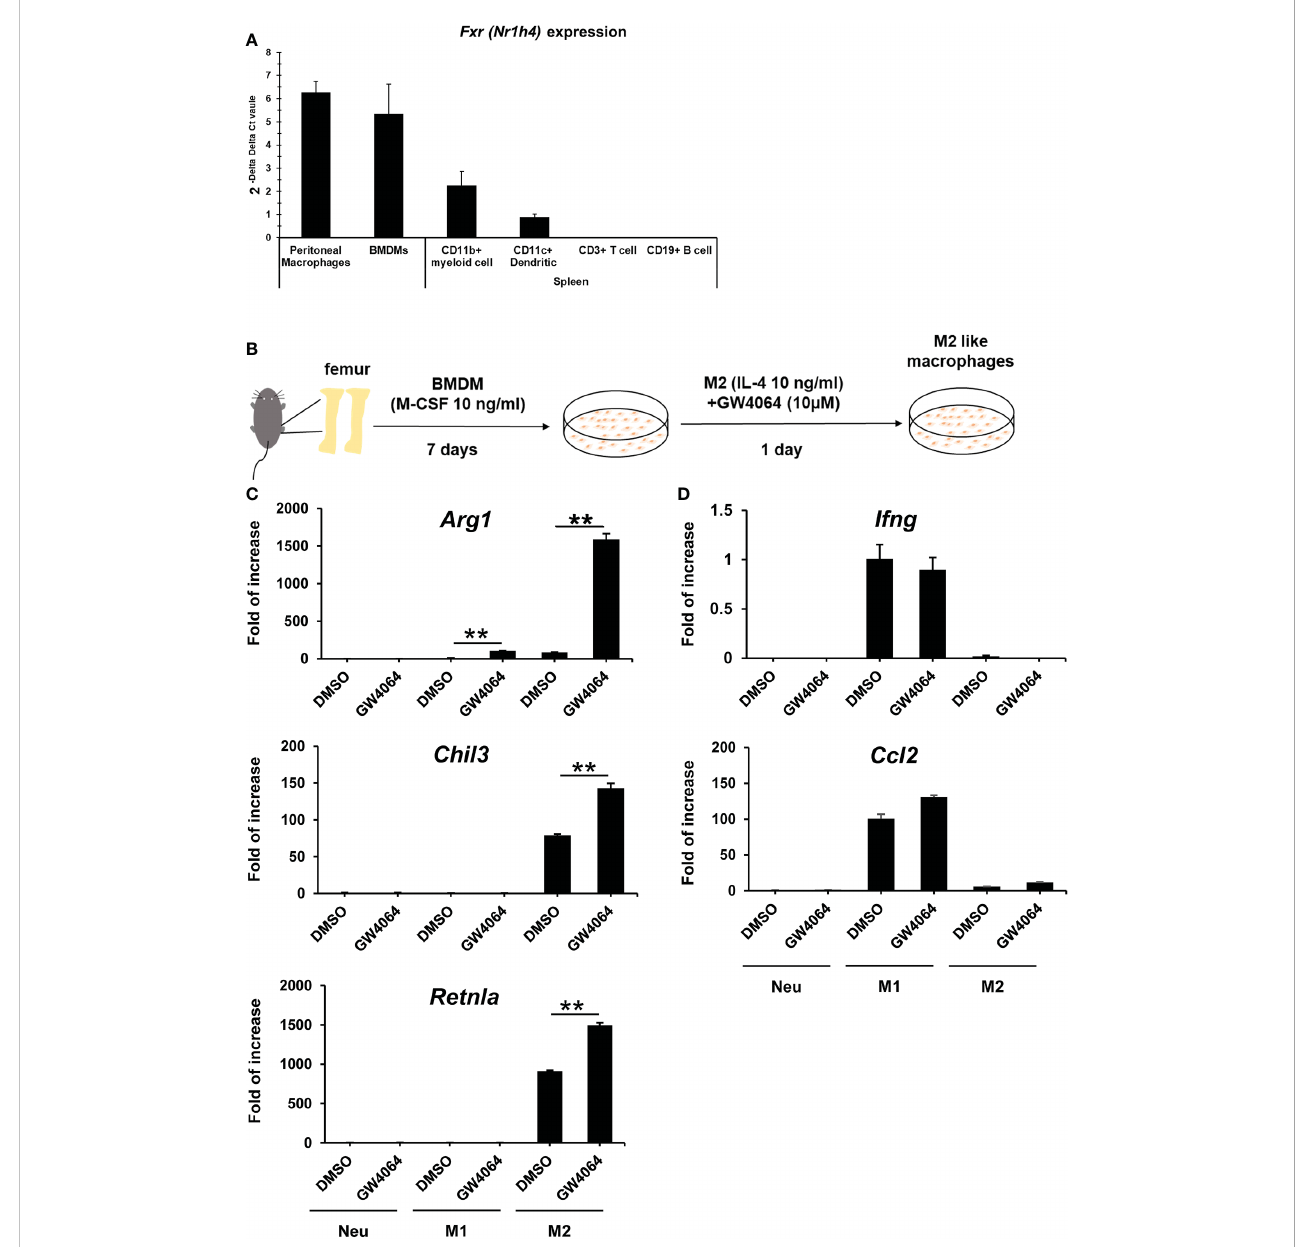
FIGURE 1 Activation of FXR in macrophages by GW4064 treatment selectively enhances M2- but not M1-associated genes. (A) mRNAs from peritoneal macrophages, BMDMs, splenic myeloid cells, dendritic cells, T cells, and B cells were extracted and converted to cDNA. Relative FXR mRNA gene ( Nr1h4 ) expression in these cells was determined by real-time PCR. (B) Schematic representation of the M2 macrophage polarization protocol. Bone marrow cells were isolated from mice femurs and cultivated for 7 d in the presence of recombinant M-CSF to become BMDMs. M2 polarization was then induced for 1 d using 10 ng/mL of recombinant IL-4. (C) BMDMs were treated with 10 µM of GW4064 under M1 or M2 macrophage-inducing conditions and left untreated as a Neu condition for 1 d. RT-qPCR analysis for M2-related genes was then conducted. (D) Real-time PCR analysis for M1-related genes was performed by using the same samples used in (C) . Each experiment was performed in triplicate and repeated three times. The results are representative data, expressed as mean +/- standard deviation. Analysis of variance (ANOVA) was used for the statistical analysis. ** P < 0.01. Nr1h4 , nuclear receptor subfamily 1 group H member 4; M-CSF, macrophage colony-stimulating factor; Neu,